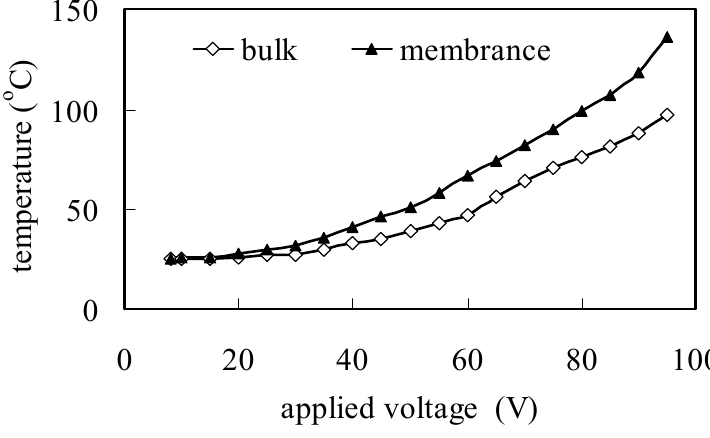
Figure 8. Variations of micro-heater temperature with magnitude of supplied electrical voltage for flow meters on diaphragm and bulk structure,